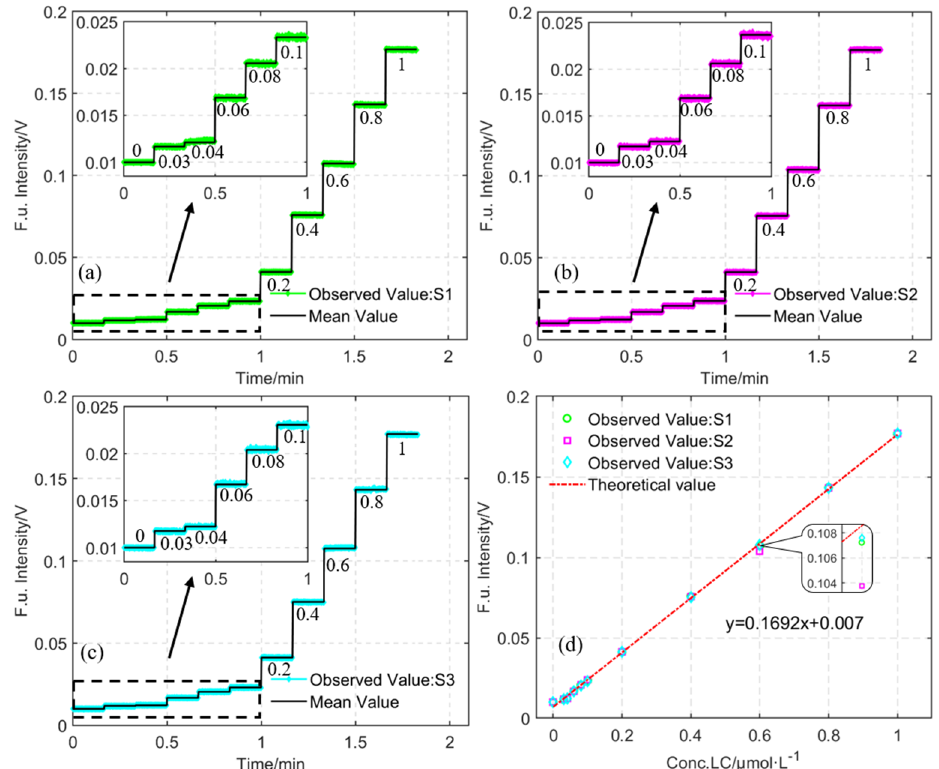
Figure 7. Results of lucigenin solution concentrations measured using the integrated module: Sam- ples 1 ( a ), 2 ( b ), and 3 ( c ) are presented. ( d ) Linear association between lucigenin solution concentrations and values observed using the integrated module.